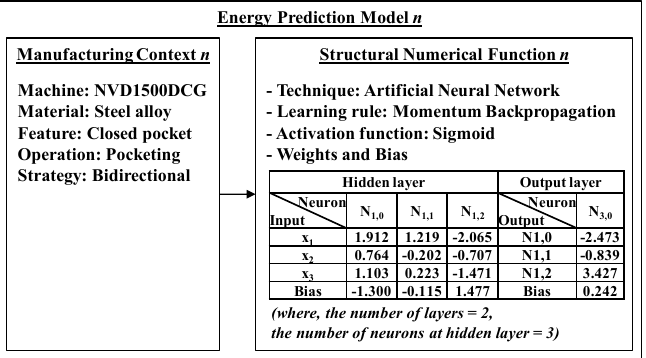
Figure 6. Structure of an energy prediction model.